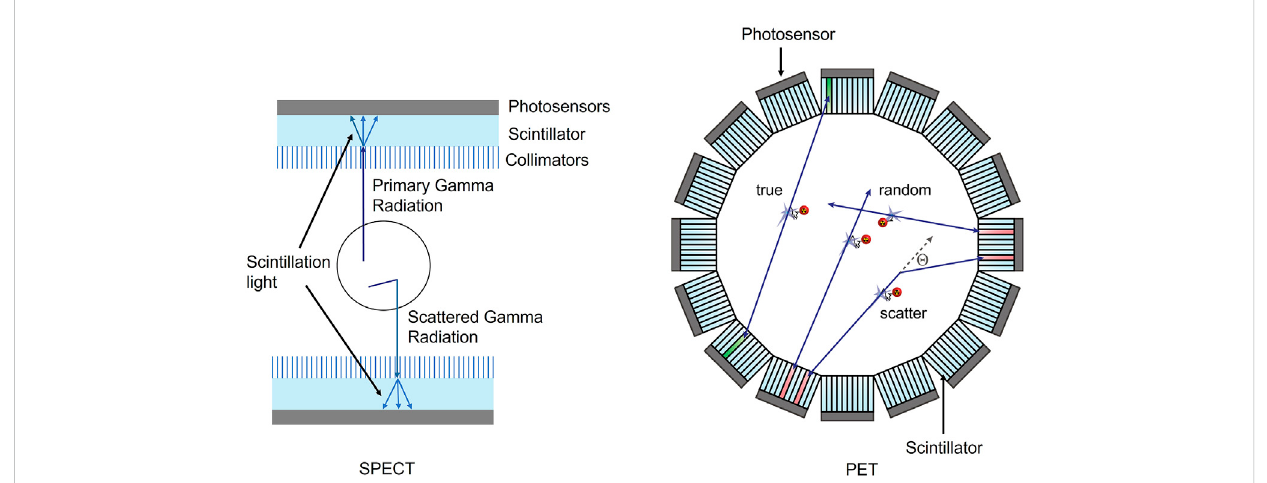
FIGURE 1 SPECT basic set-up comprising of photosensors, scintillators, and collimators in a dual head system both primary and scattered gamma radiation is allowedthroughthecollimatorandproducesscintillatorlightinthescintillatorcrystal(left).PETbasicset-upcomprisingofphotosensorsandscintillators surrounding the subject (right). Reproduced under CC-BY 4.0 license from